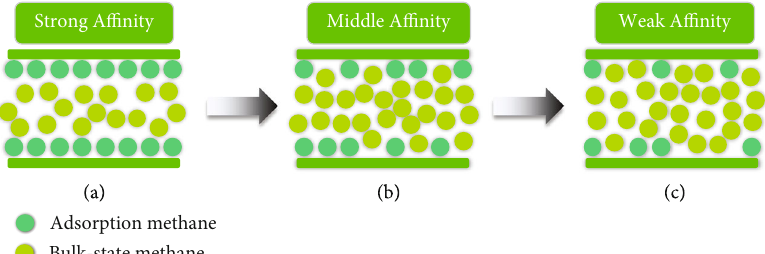
Figure 1: Fluid molecular distribution and fl ow characteristics: (a) Strong a ffi nity; (b) Middle a ffi nity; (c) Weak a ffi